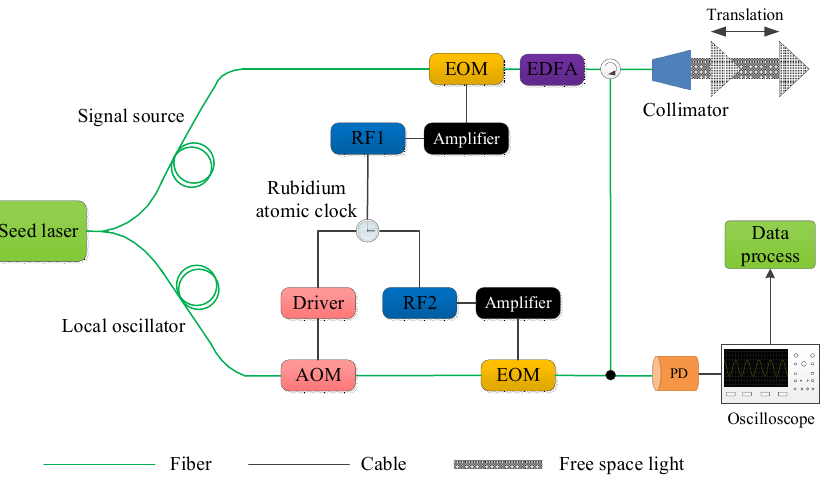
Figure 1. Experimental system for the dual optical comb laser Doppler velocimeter (LDV). Legend: RF1, RF driver1; RF2, RF driver2; EOM, electro-optic modulator; AOM, acousto-optic modulator; EDFA, Er-doped fiber amplifier; PD, photodetector.